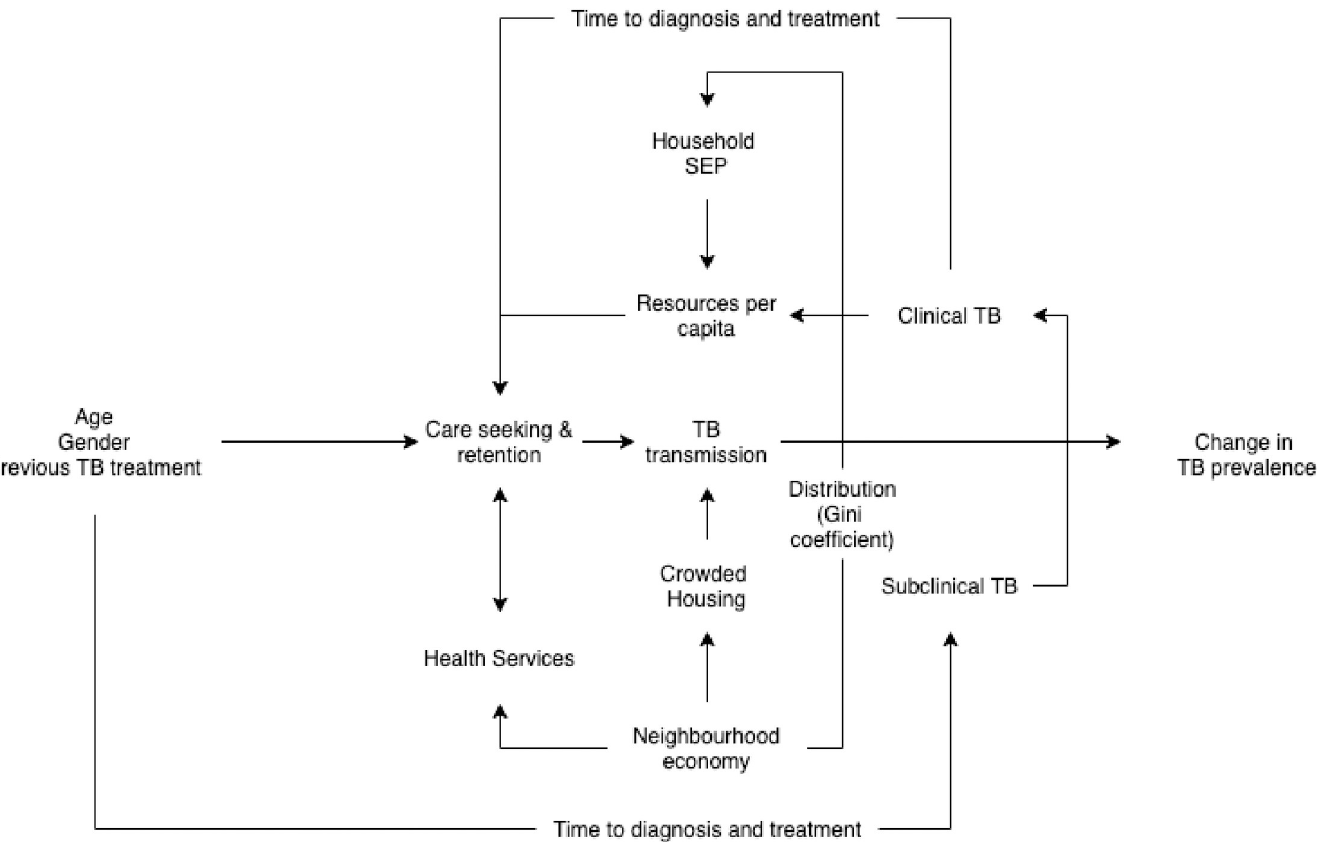
Fig 1. Causal diagram of social determinants of tuberculosis prevalence in Vie ˙ˆt Nam. SEP, socioeconomic position; TB, tuberculosis.